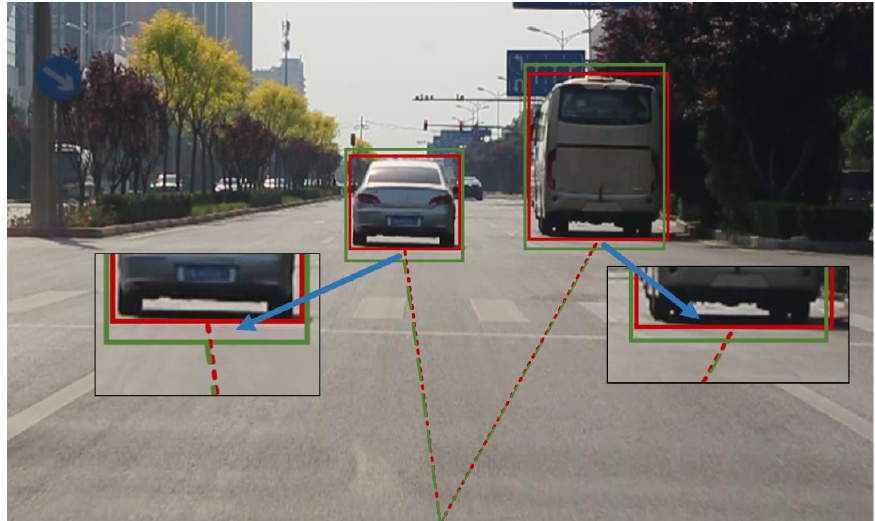
Figure 4. Unstable traffic object detection. Bounding boxes with different aspect ratios can make the decision module make wrong judgments. For example, the monocular ranging algorithm obtains different results and affects the decision of automatic emergency braking.